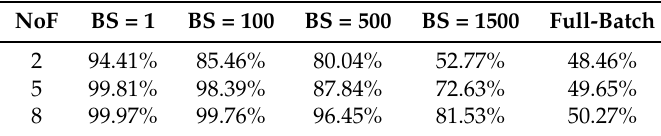
Table 4. Effect of GA-based feature selection on the designed MLP’s performance ( HLN = 30).